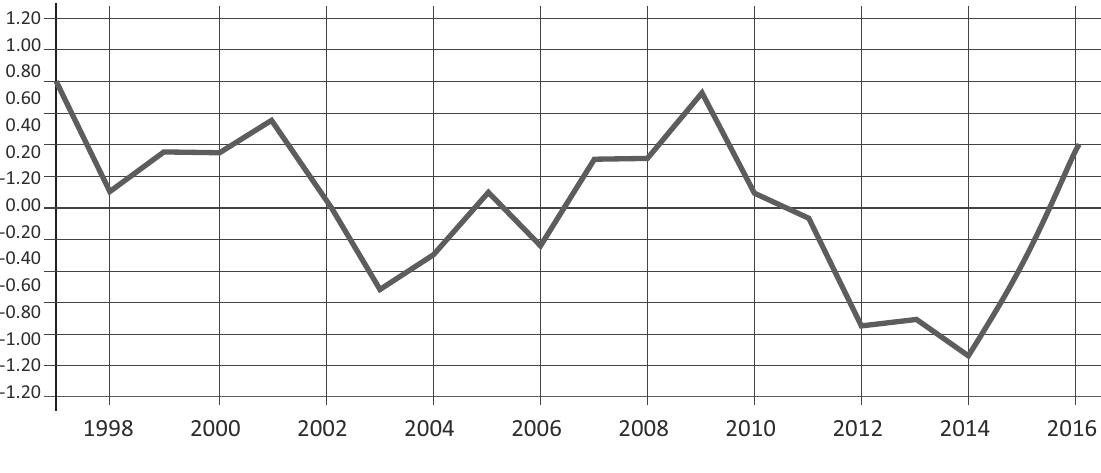
Figure 2. The Kauffman Index of startup activity (1997–2016)